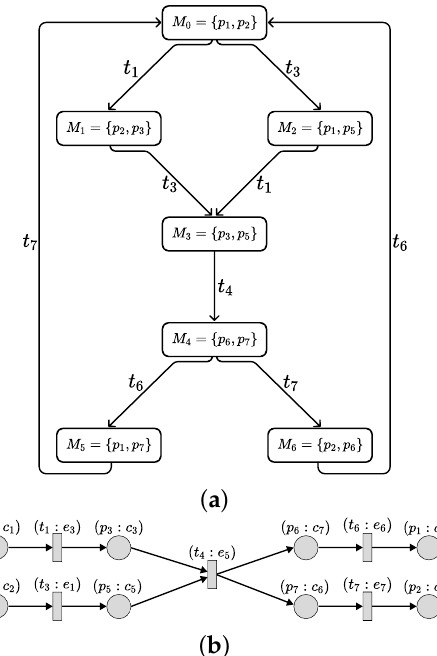
Figure 3. A pictorial representation of the different nets semantics. ( a ) A sub-reachability graph representing the interleaving semantics of the occurrence sequence in Figure 1b. ( b ) An occurrence net representing the true concurrency semantics of the occurrence sequence in Figure